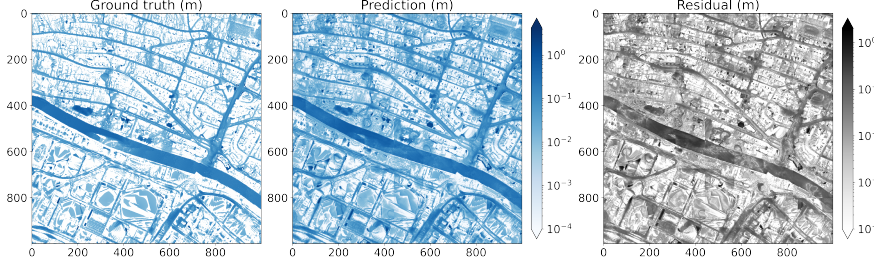
residual of ground truth and predicted reconstruction for the same area.